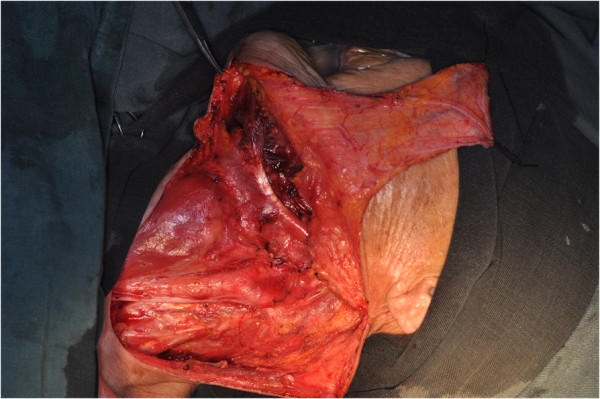
Neck dissection was completed with the facial artery and vein ligated.